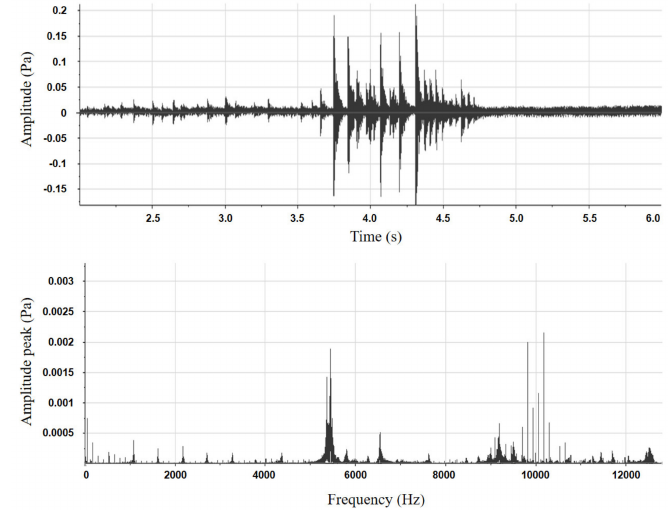
Figure 12. Collision sound pressure and frequency for 9.53-mm bed-load particle